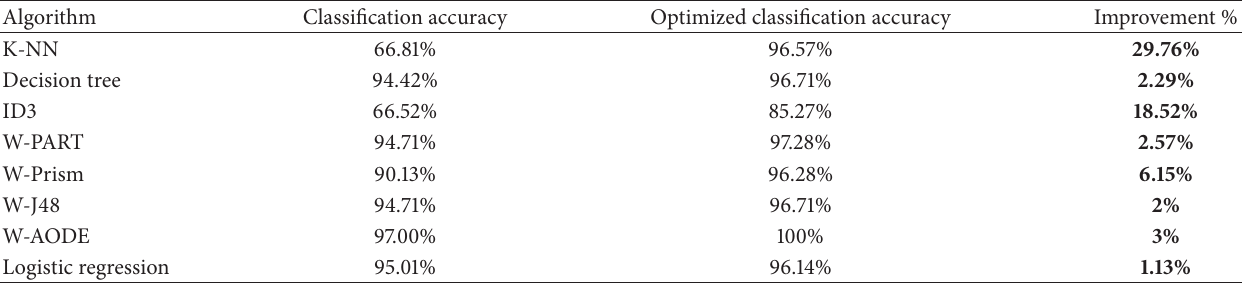
Table 6: Results for cancer dataset: comparison of optimized classification accuracy using GMC model with simple classification using different classifiers.